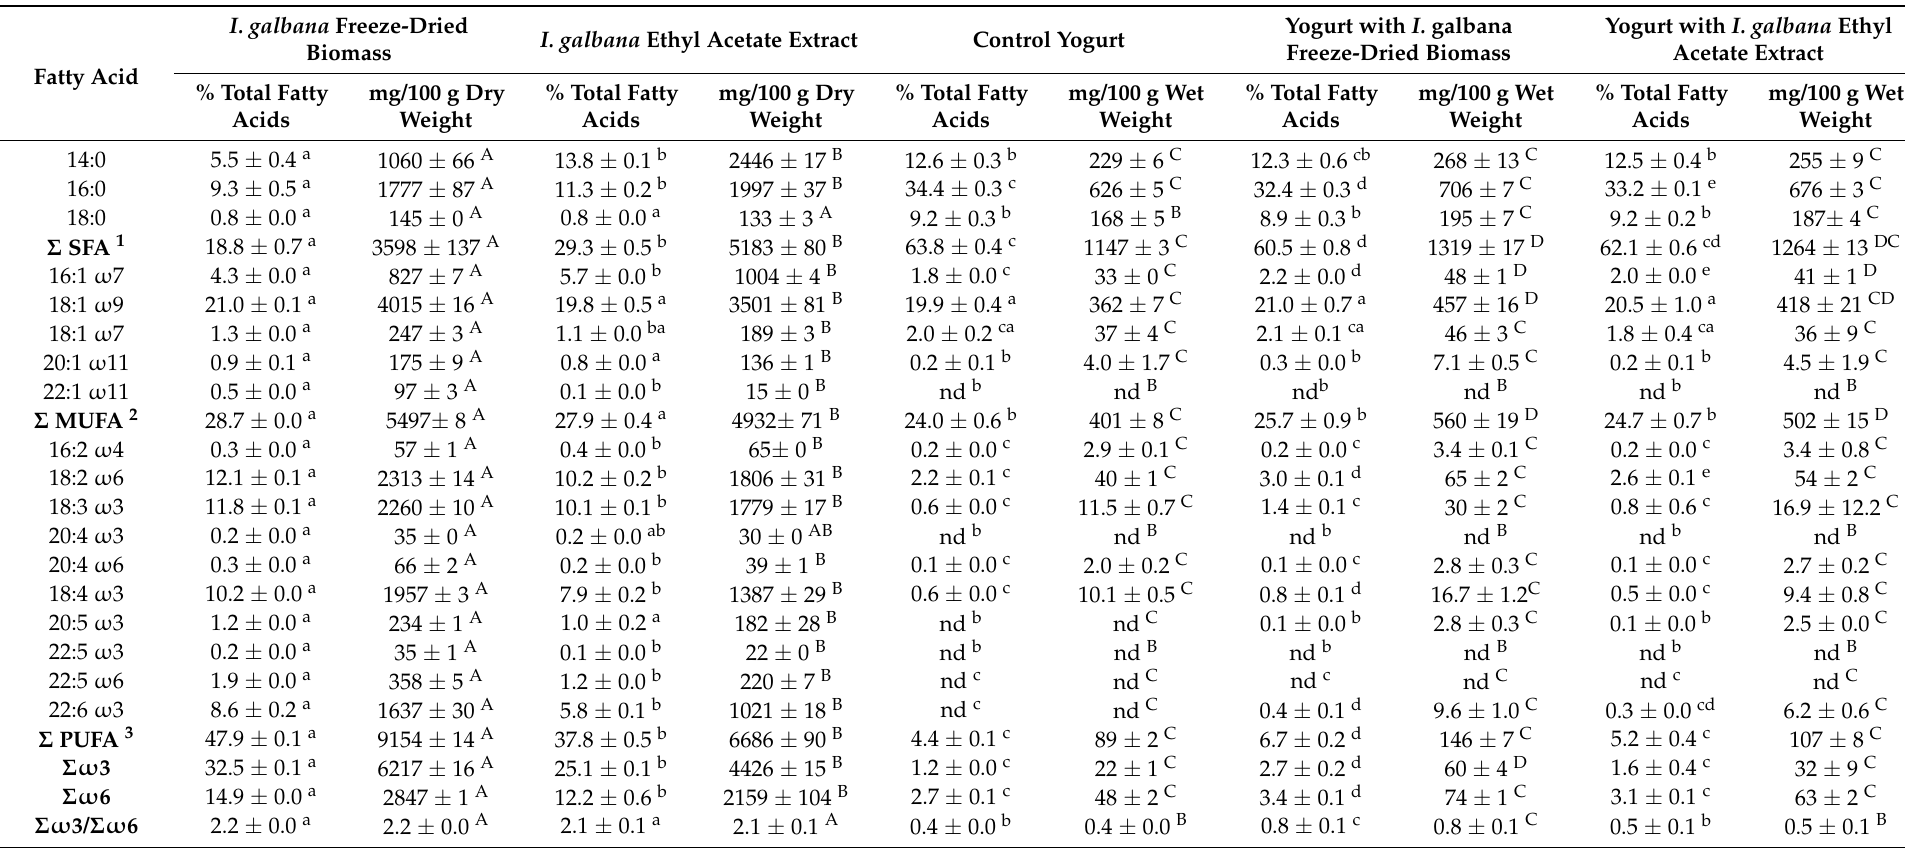
Table 3. Fatty acid profile (in % of total fatty acids and in mg/100 g dry weight or wet weight) of I. galbana freeze-dried biomass and I. galbana ethyl acetate extract, of control yogurt, yogurt with 2% ( w / w ) of I. galbana freeze-dried biomass and yogurt with 2% ( w / w ) of I. galbana ethyl acetate extract.